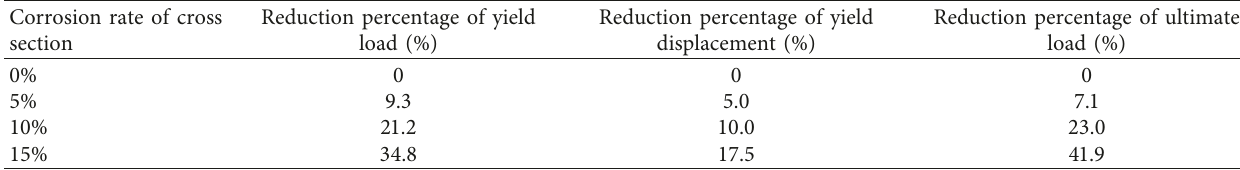
Table 9: Comparison of parameter lower rate and corrosion rate.